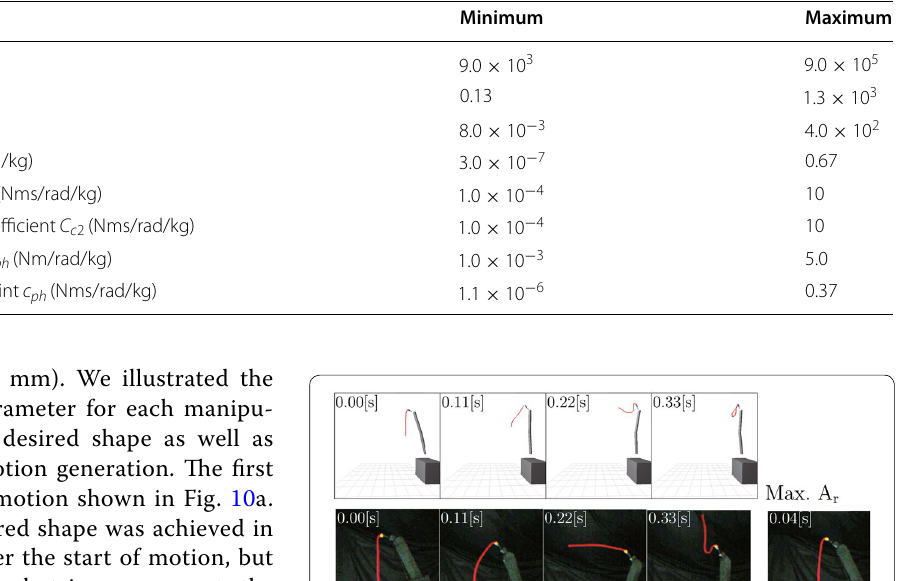
Table 2 Range for parameter estimation